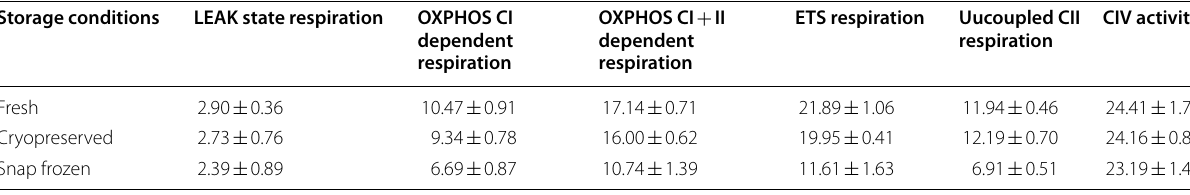
Table 1 Placental respiratory